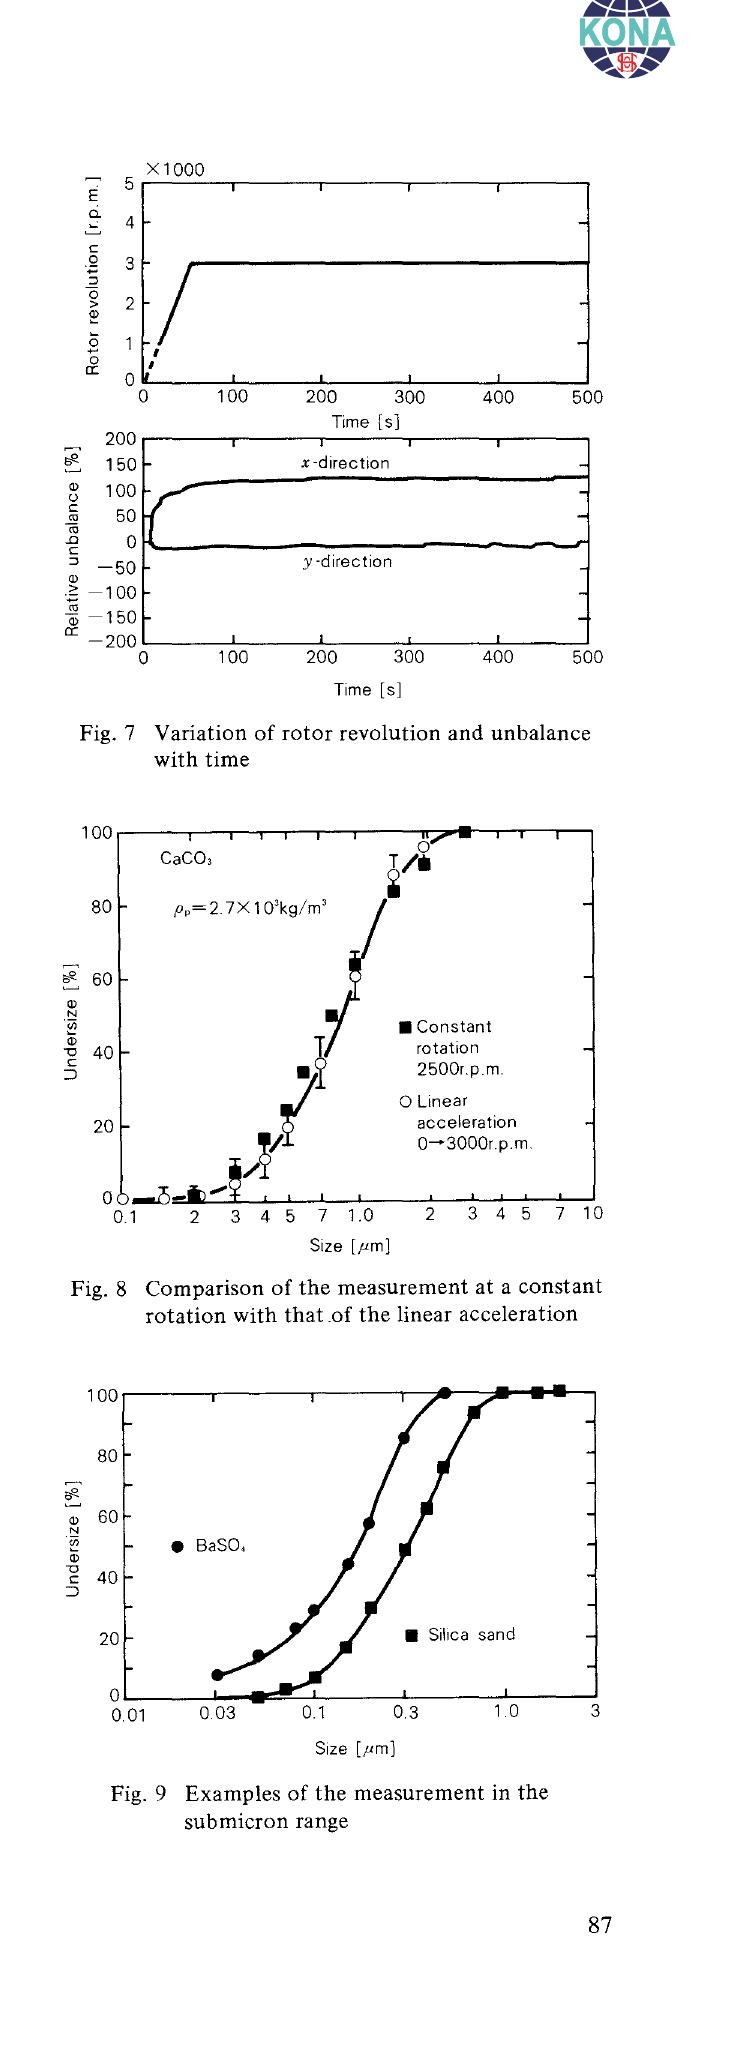
Fig. 9 Examples of the measurement in the submicron